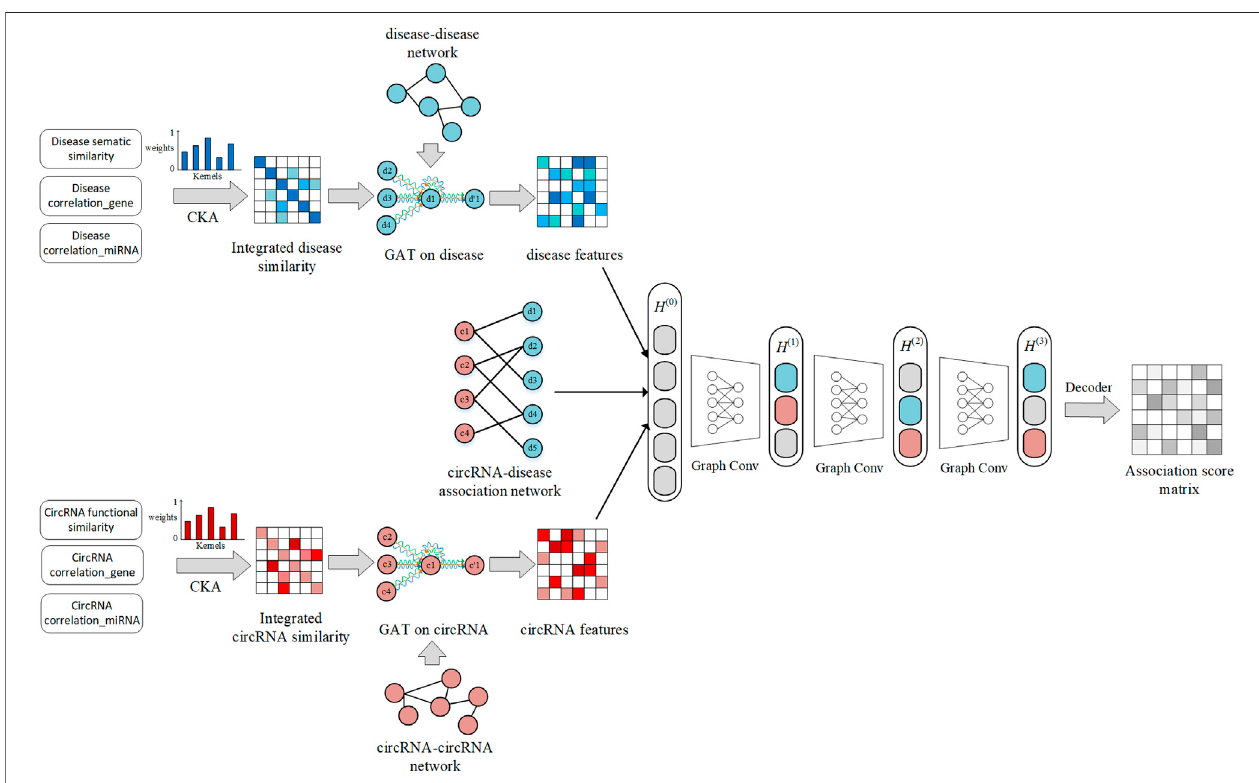
FIGURE 1 | Overall work fl ow of the